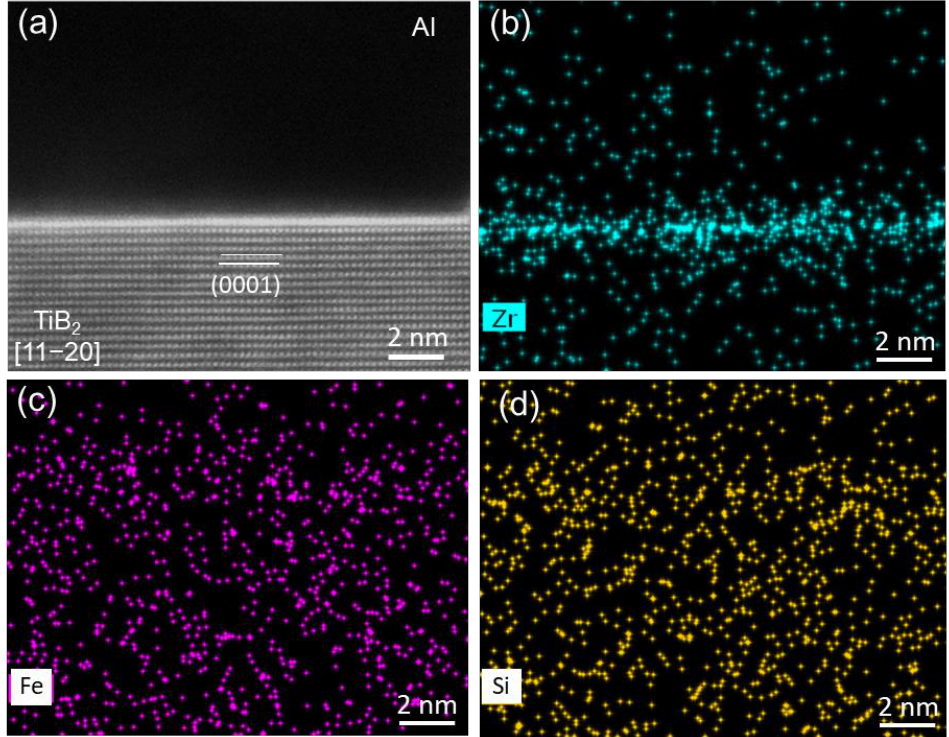
Figure 10. Zr segregation at Al/TiB 2 interface [26]. ( a ) STEM-HAADF image across Al/TiB 2 interface viewed along [1 1 2̅ 0]TiB 2 direction, and ( b – d ) super-X EDS elemental mapping of ( b ) Zr (cyan), ( c ) Fe (purple) and ( d ) Si (yellow) across the interface, showing Zr segregation but no segregation of Fe and Si at the interface.